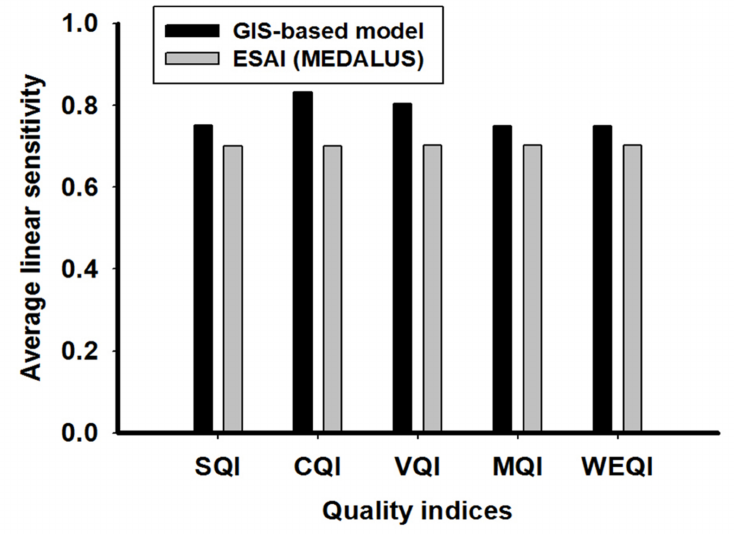
Figure 9. Average linear sensitivity of the input parameters for the proposed model and